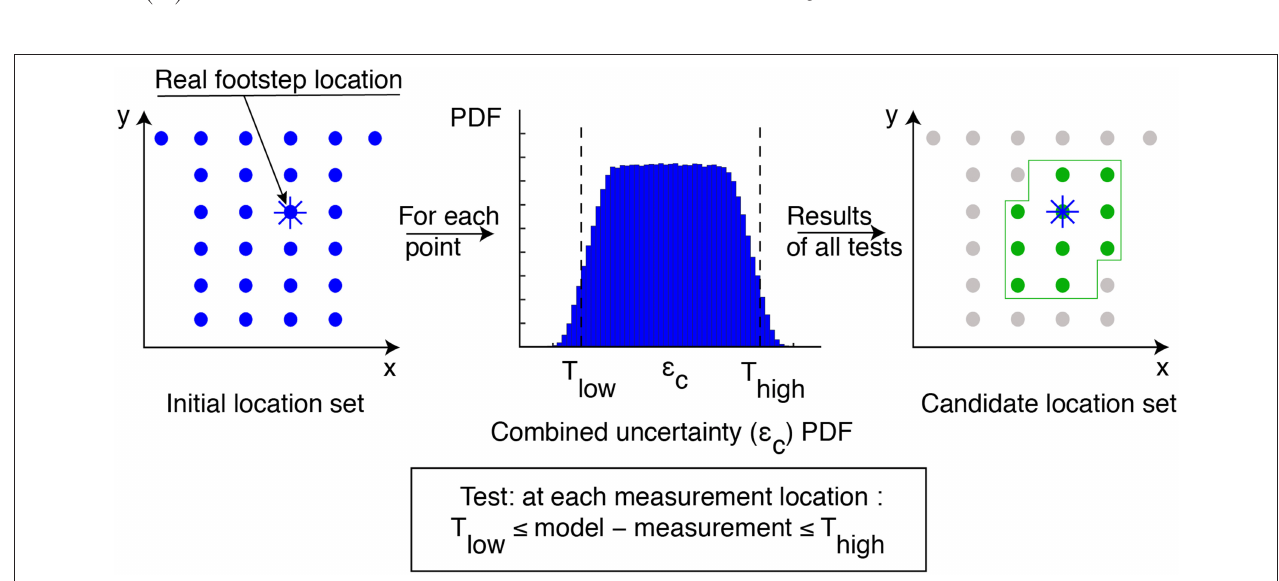
FIGURE 2 | Trajectory identification using error-domain model-falsification starts with an initial location set. Model simulations are compared with measured response in order to identify candidate locations among the initial population. Threshold boundaries are derived from combined uncertainties. Model instances are falsified when the residual value between simulations and measurements exceeds thresholds at any sensor location.